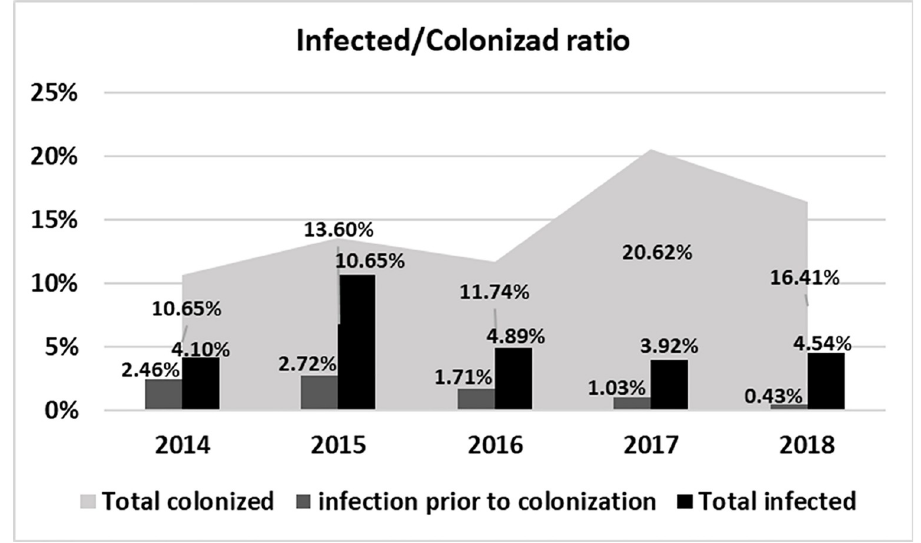
Fig 1. Analysis of infection rates prior to colonization and of total colonized and total infected